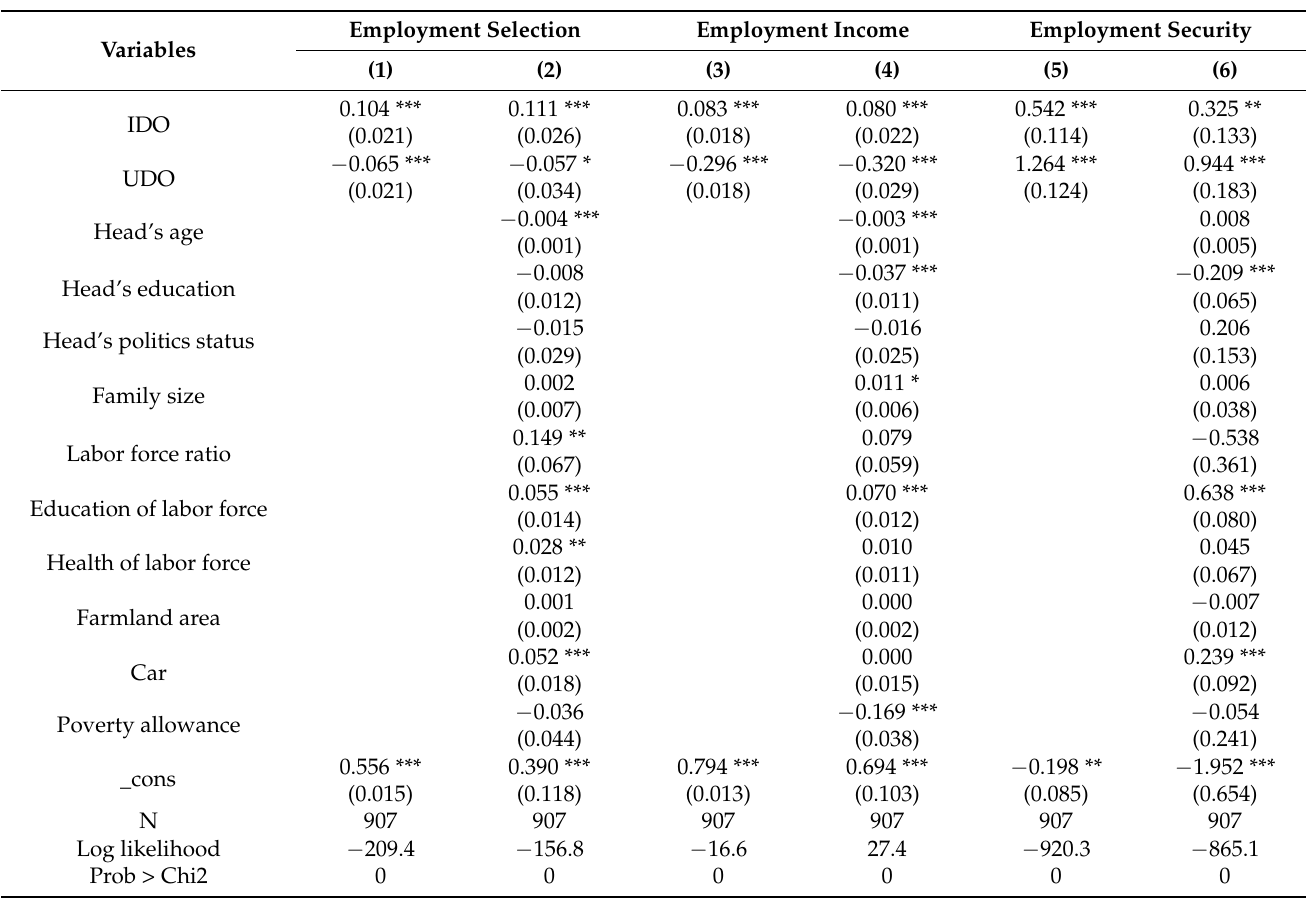
Table 2. Regression results of the impact of heterogeneous land development opportunities on rural household